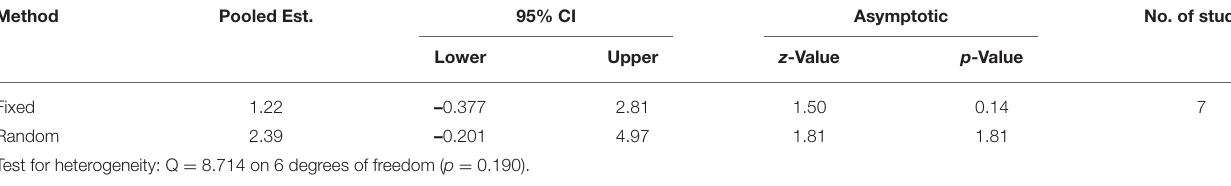
TABLE 6 | Trim and fill analysis of stillbirth among diabetic women in Ethiopia, 2020